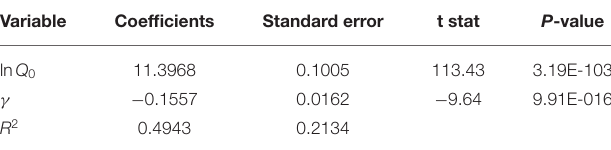
TABLE 3 | Countries with > 20 % reduction in OOP% from 2000 to